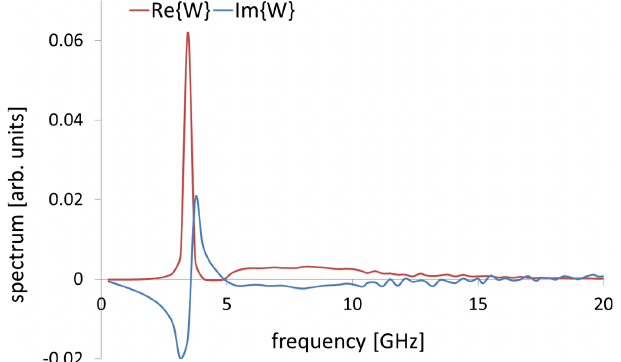
FIG. 14. The geometry (blue lines) of the IR near one of the pipe connections with a fragment of the top wall (red colored plate) with the longitudinal coupling slots. Grey lines show the electric force line of the mode. Electric force lines that can be seen through the slots are perpendicular to the slot. That means that the mode field can escape out through these slots. The slot dimensions and number of them will be optimized for better absorption of the trapped mode.